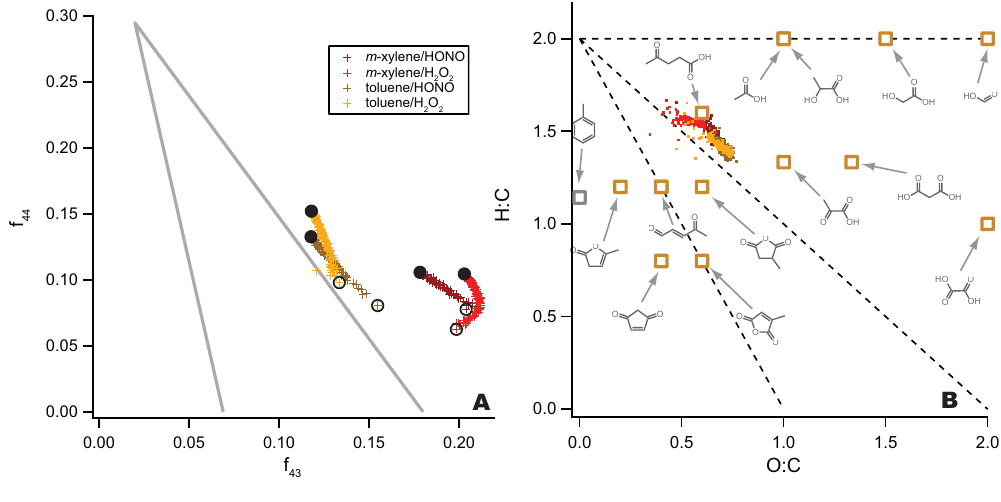
Fig. 4. (A) “Triangle plot” for SOA formed from photooxidation of toluene and m -xylene under low- and high-NO x conditions. Open and closed black circles represent the beginning and end of the experiments, respectively. (B) Van Krevelen diagram for SOA formed from photooxidation of isoprene under low- and high-NO x conditions. Identified toluene-SOA products are presented in tan boxes (Sato et al., 2007; Hamilton et al., 2005; Bloss et al., 2005; Fisseha et al., 2004; Jang and Kamens, 2001; Kleindienst et al., 2004; Edney et al., 2003). Substantial mass closure has been difficult to achieve in molecular characterization